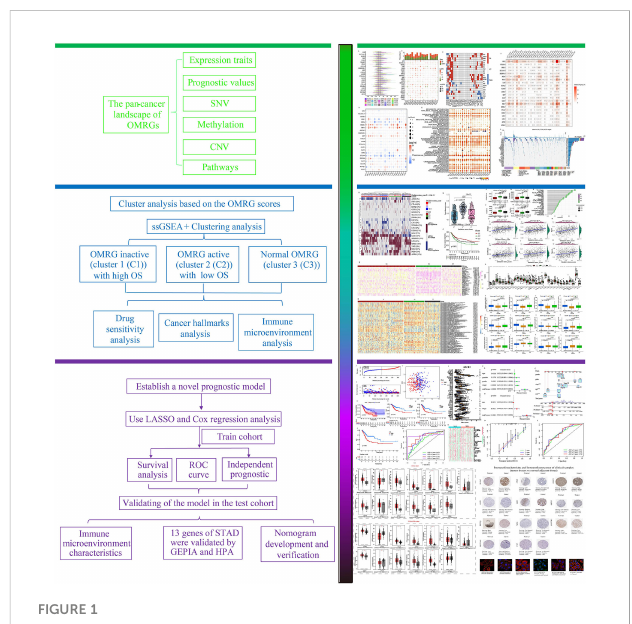
FIGURE 1 The fl owchart of the research